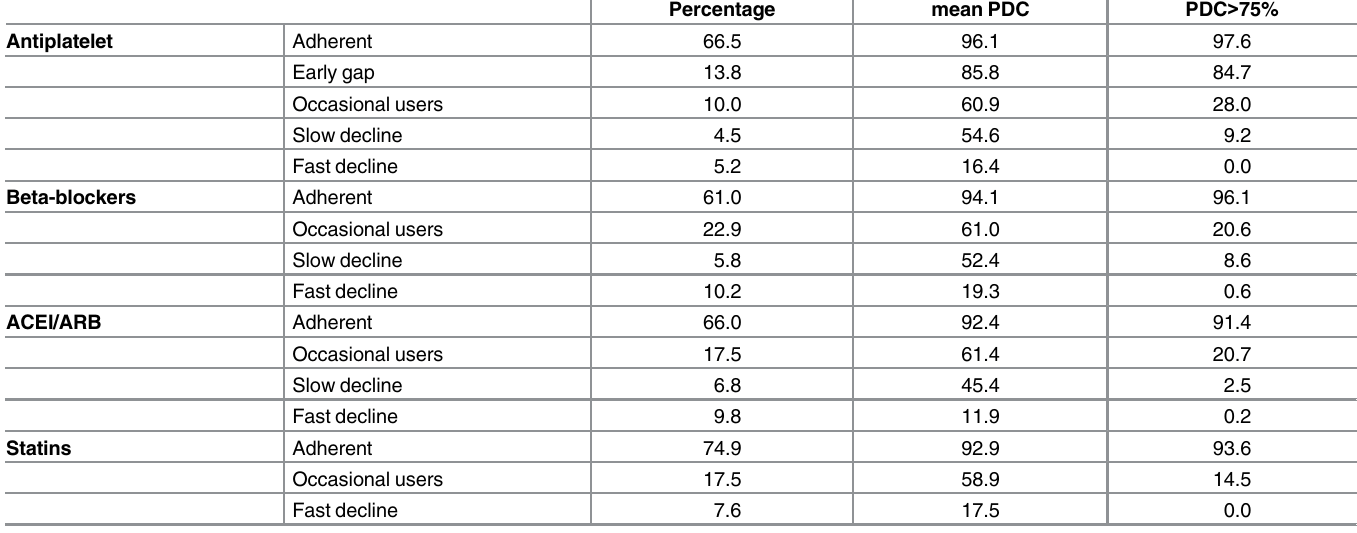
Table 2. Adherence for the 9-month follow-up for each trajectory and therapeutic